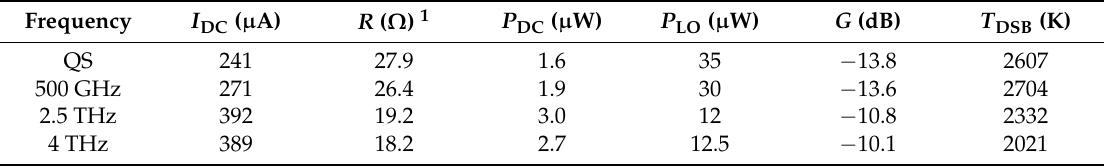
Figure 15. For an HEB constriction of dimensions L = w = 400 nm and θ = 35 nm (Figure 1), maps exhibiting double sideband noise temperature T DSB levels in DC bias power vs. LO power coordinates. Impedance matching coefficient with the antenna was not included ( α imp = constant = 1). Table 4. For an HEB of dimensions L = w = 400 nm and θ = 35 nm at different operating frequencies, with unit impedance matching coefficient ( α imp = 1), compared performances at an optimal operating point with respect to the noise temperature.